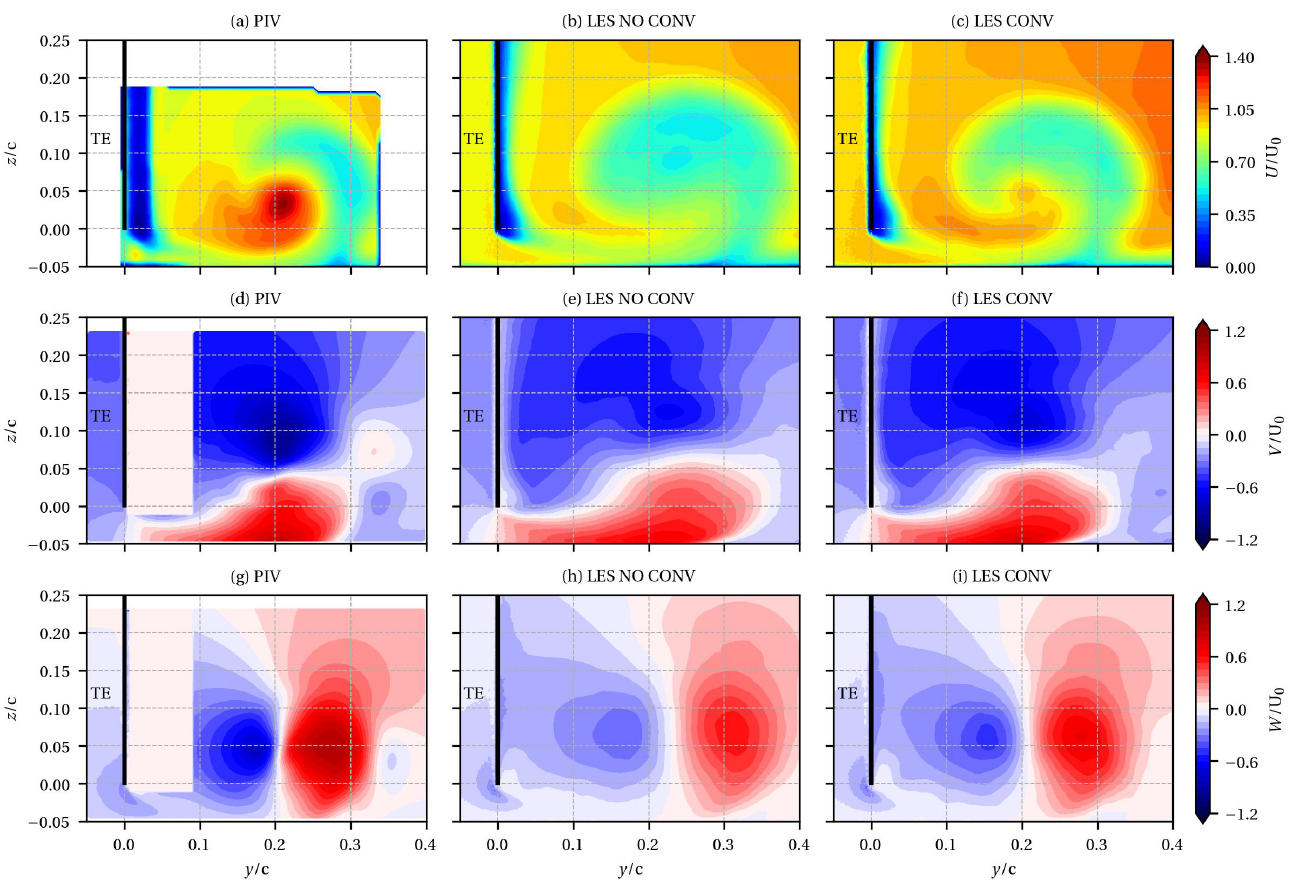
Figure 7. Streamwise U , horizontal V , and vertical W mean velocity components of the tip leakage vortex at the airfoil trailing edge ( x /c =